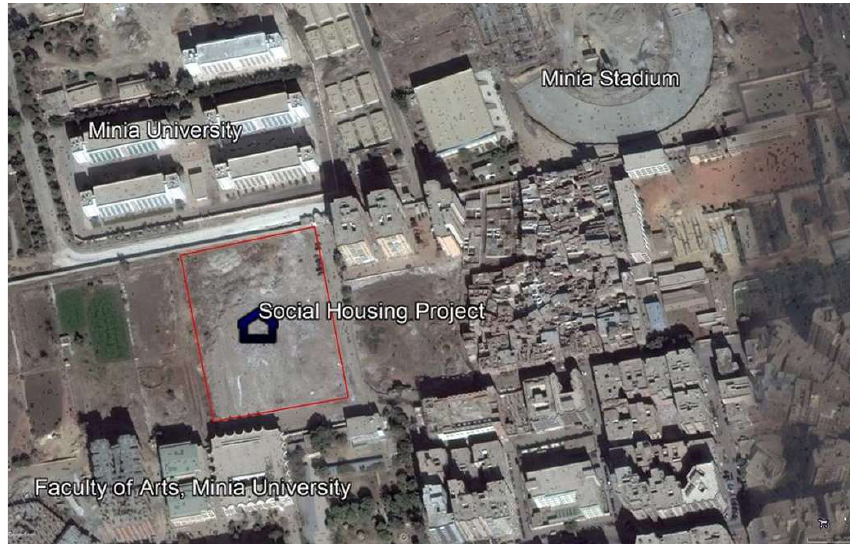
Figure 5. Location of the investigated project.